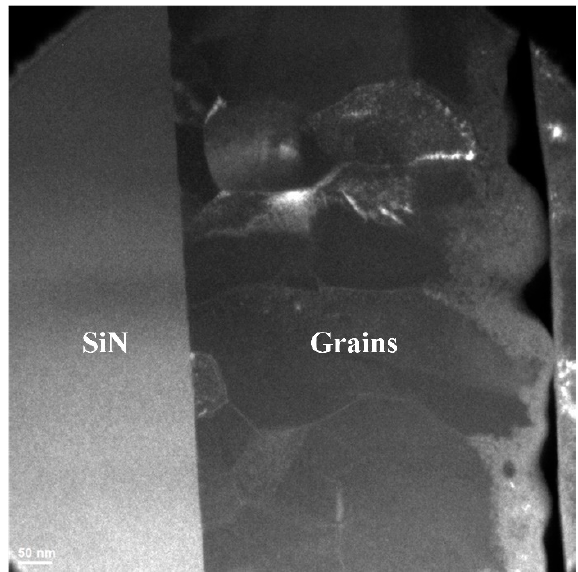
Figure 4. Lattice-oriented selective TEM photograph. Left part is SiN, and right part is polycrystalline silicon. Different grains have different luminances in the picture since they have different lattice orientations.